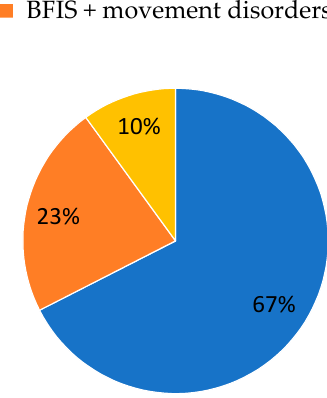
Figure 1. Distribution of clinical manifestations in a cohort with BFIS (core cohort, n = 40).